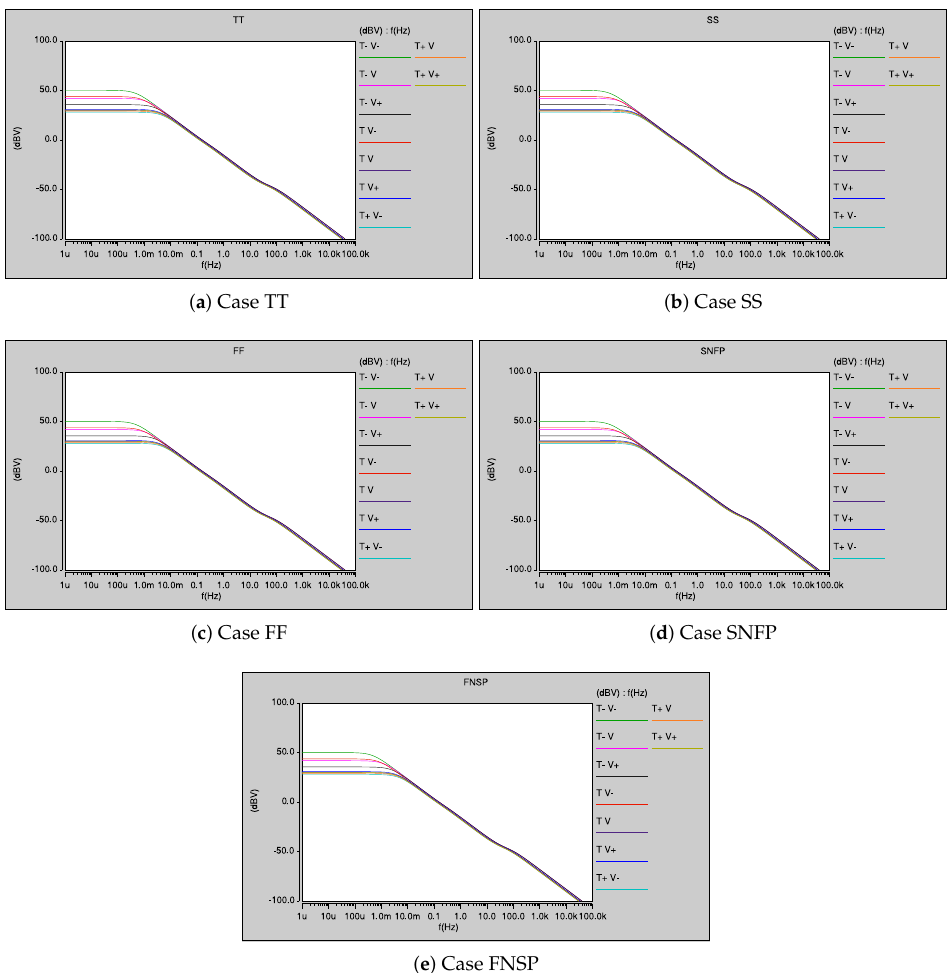
Figure 18. Process–voltage–temperature (PVT) variation simulations of the CMOS fractional-order integrator shown in Figure 16.